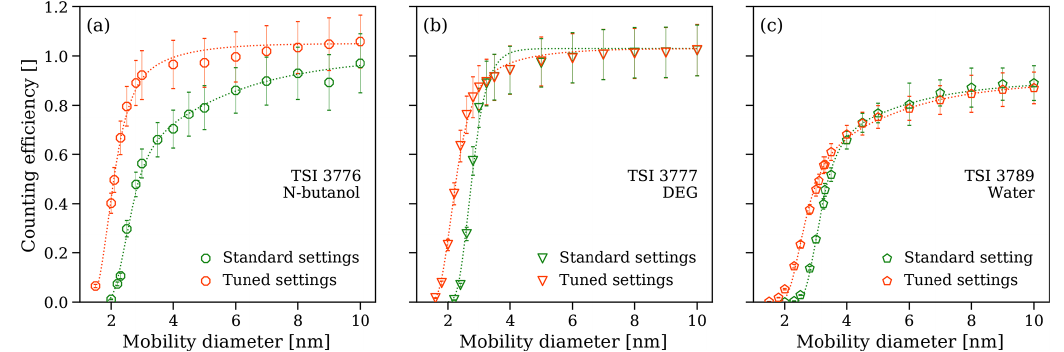
Figure 6. Detection efficiencies of the tuned instruments: the figure shows the detection efficiencies for BCYO x seeds as a function of the electrical mobility equivalent diameter. The green lines correspond to the standard settings, and the orange lines correspond to the tuned settings. Every plot shows data from a different instrument: TSI 3776 (a) , TSI 3777 (b) and TSI 3789 (c) .